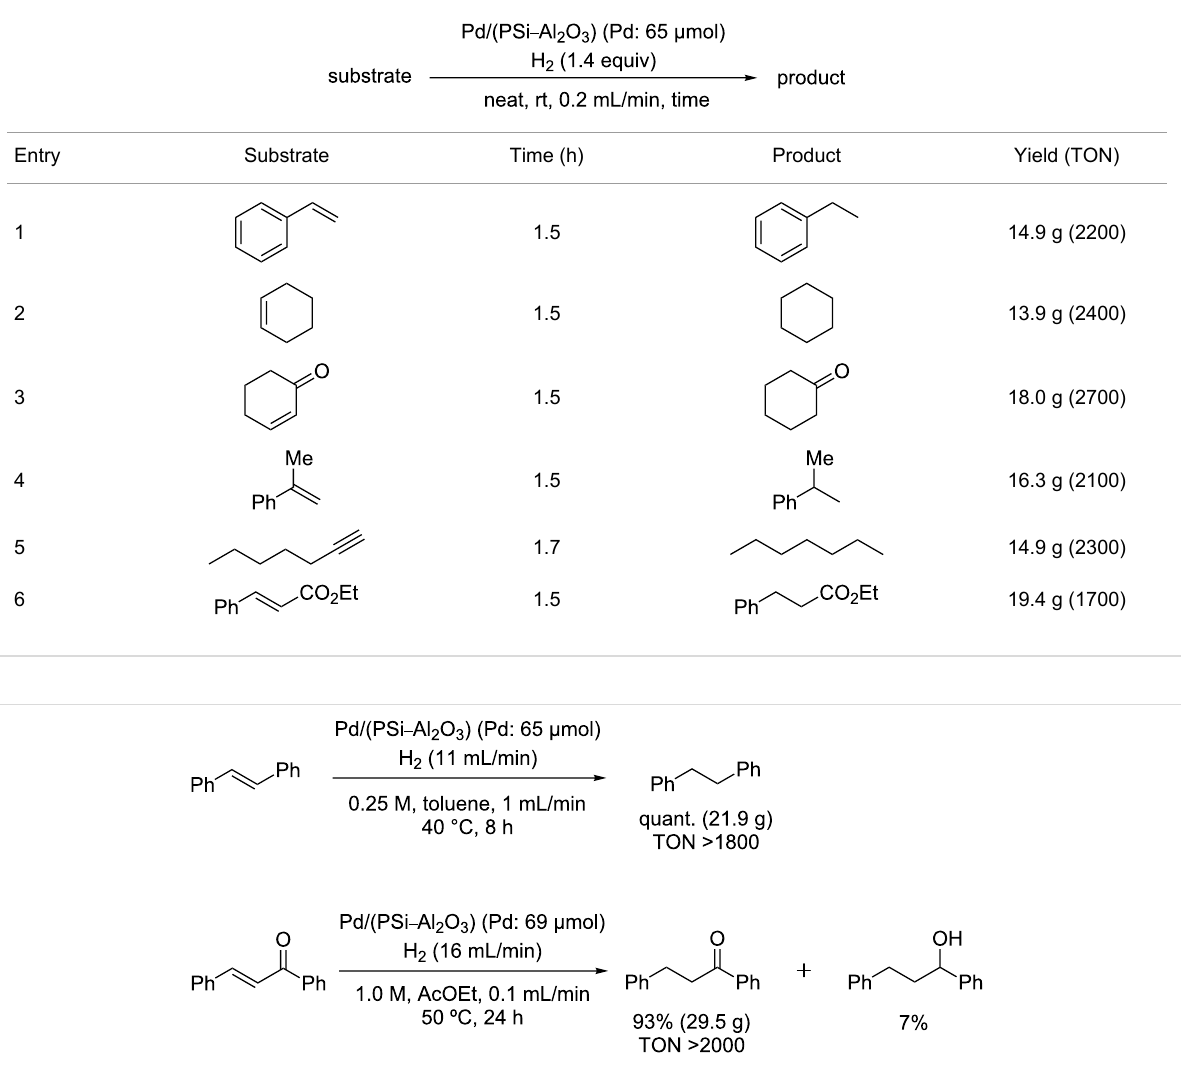
Table 1: Hydrogenation of C–C double and triple